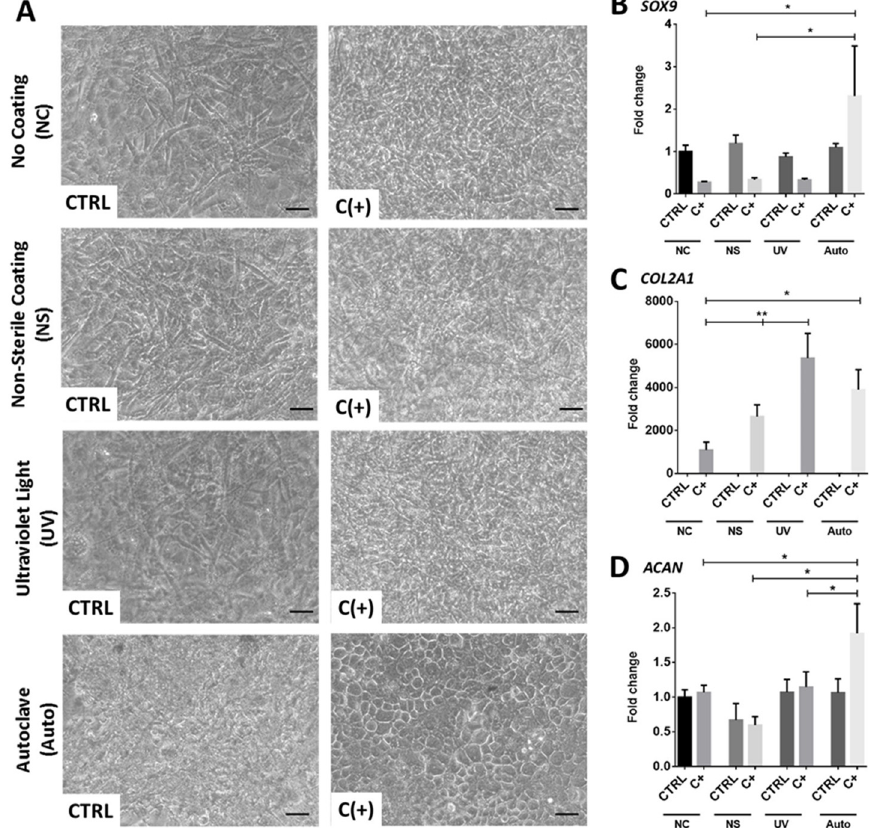
Figure 2. Skeletal cell behavior on dcECM coatings. ( A ) Brightfield microscopy images of hPDCs seeded on dcECM coatings that were either non-sterile (no post-processing sterilisation), UV sterilised, or autoclaved. The hPDCs were also seeded on non-coated tissue culture plastic. All samples were seeded in either CTRL or C(+) conditions and cultured for seven days. There was a distinct cobblestone pattern observed in hPDCs seeded onto the autoclaved dcECM coating (Scale bar = 50 µm). Chondrogenic gene expression of ( B ) SOX9 ( C ) COL2A1 and ( D ) ACAN from hPDCs seeded on non-coated surfaces or dcECM coatings under control conditions (CTRL) and C(+) chondrogenic conditions on non-coated surface (NC), non-sterile gel coating (NS), ultraviolet sterilised gel coating (UV) and autoclaved gel coating (Auto). ( n = 3 * p < 0.05, ** p < 0.01). (Fold changes normalised to CTRL NC